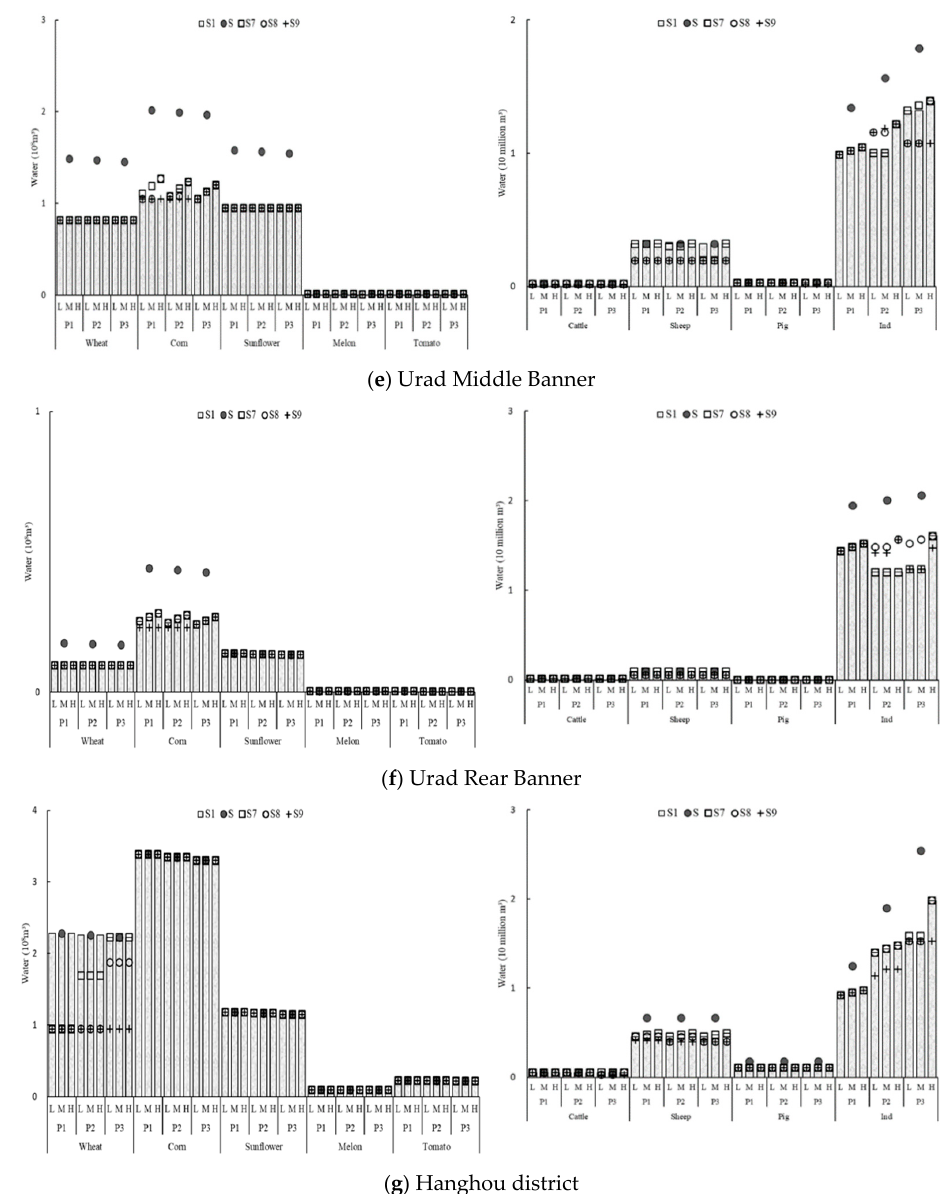
Figure 12. The overall water allocation of agriculture, livestock husbandry and industry in each district under four scenarios: S1, S7, S8 and S9.